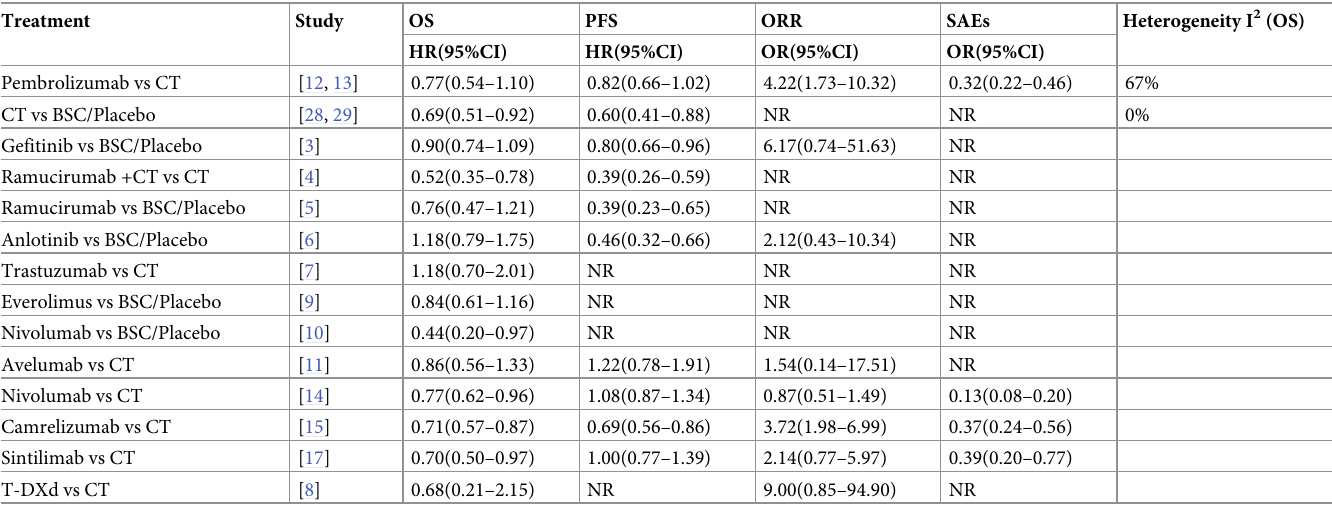
Table 2. Results of single trial and direct comparison meta-analysis.